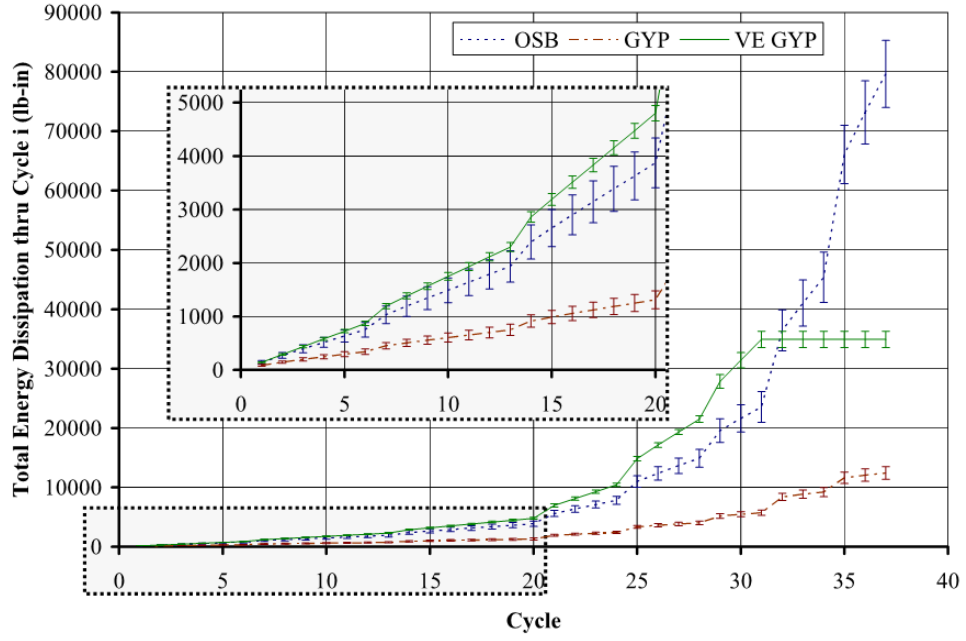
Figure 10. Total energy dissipated for all wall